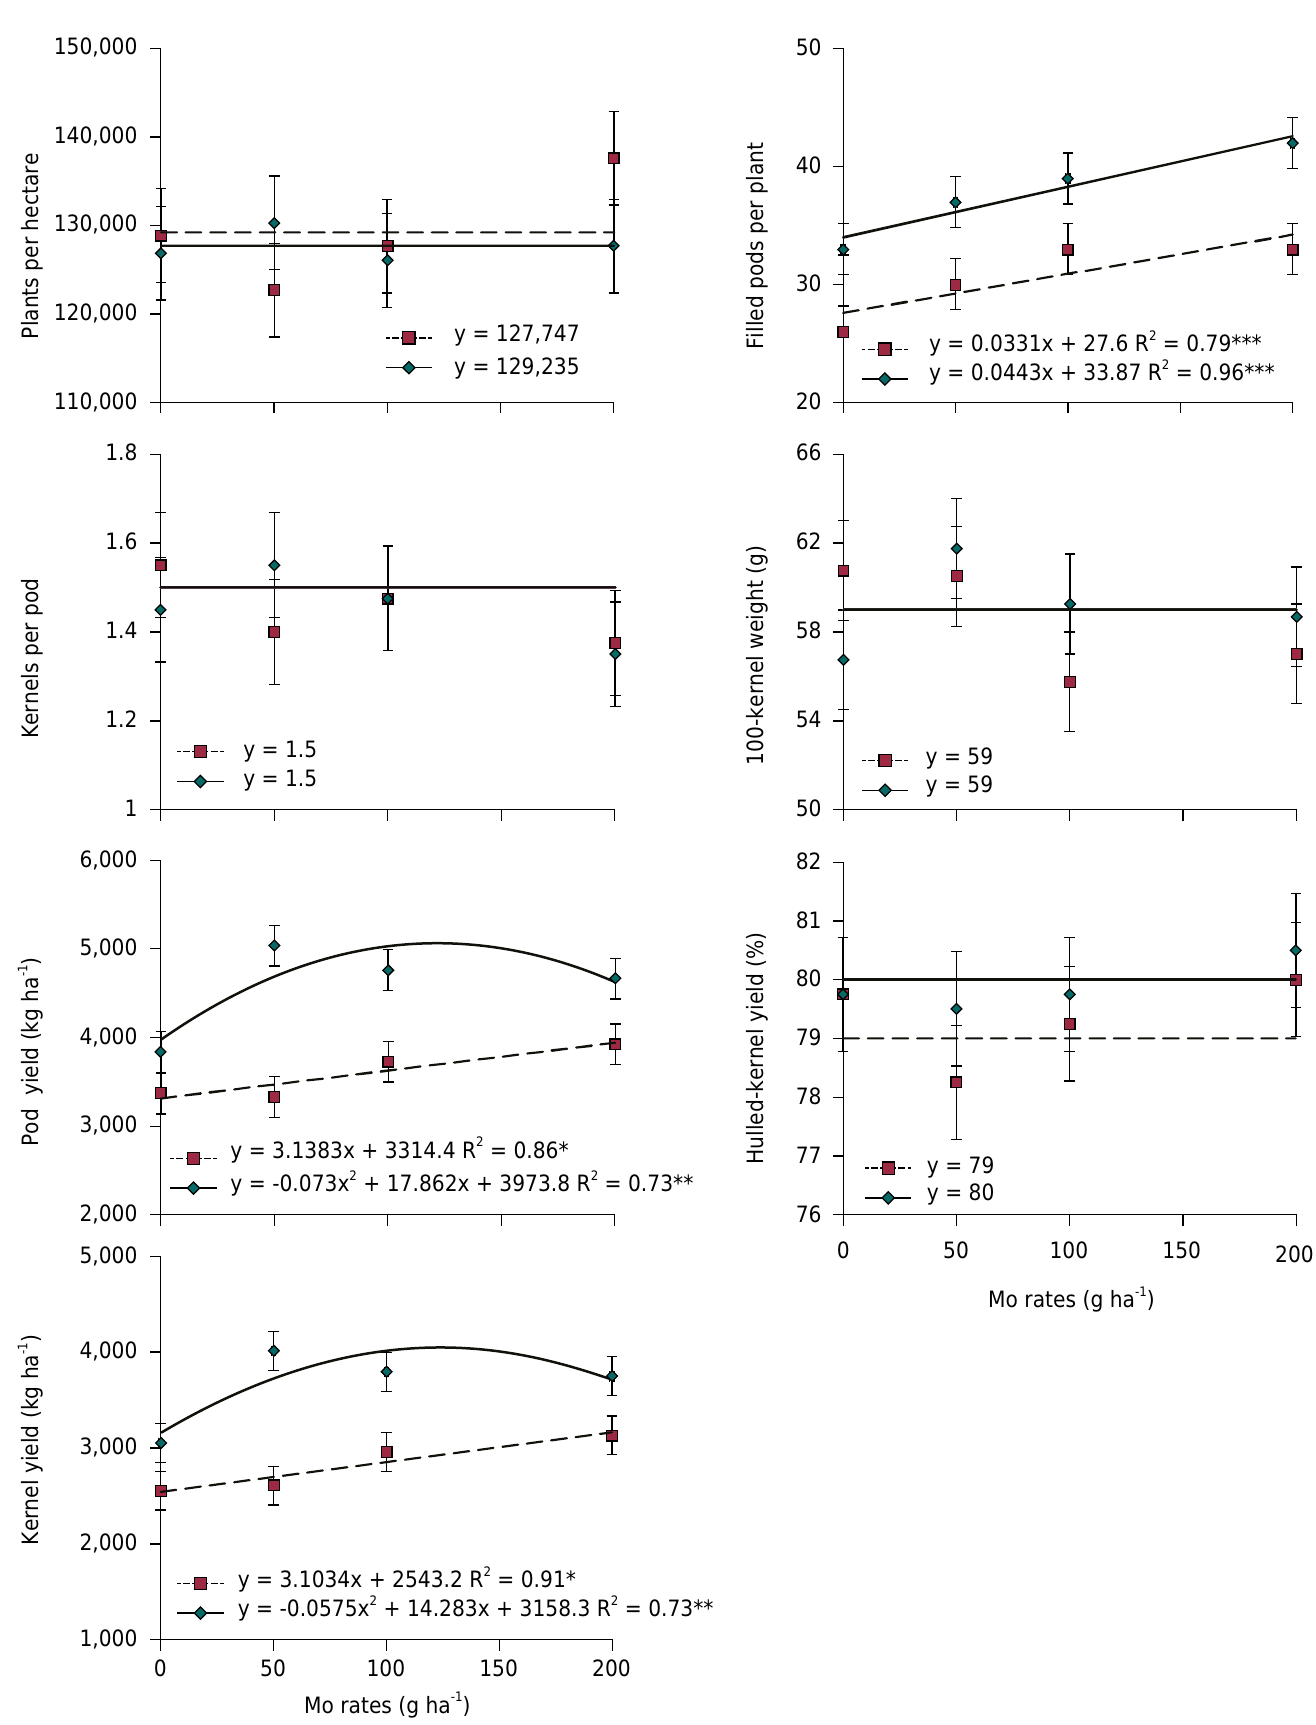
Figure 4. Number of plants per hectare, number of filled pods per plant, kernels per pod, 100-kernel weight, pod yield, hulled-kernel yield, and kernel yield as a function of Mo rate, and rhizobial inoculation [without (□) and with (♦) inoculation]. ***, **, and *, are significant at p<0.01, p<0.05, and p<0.10,